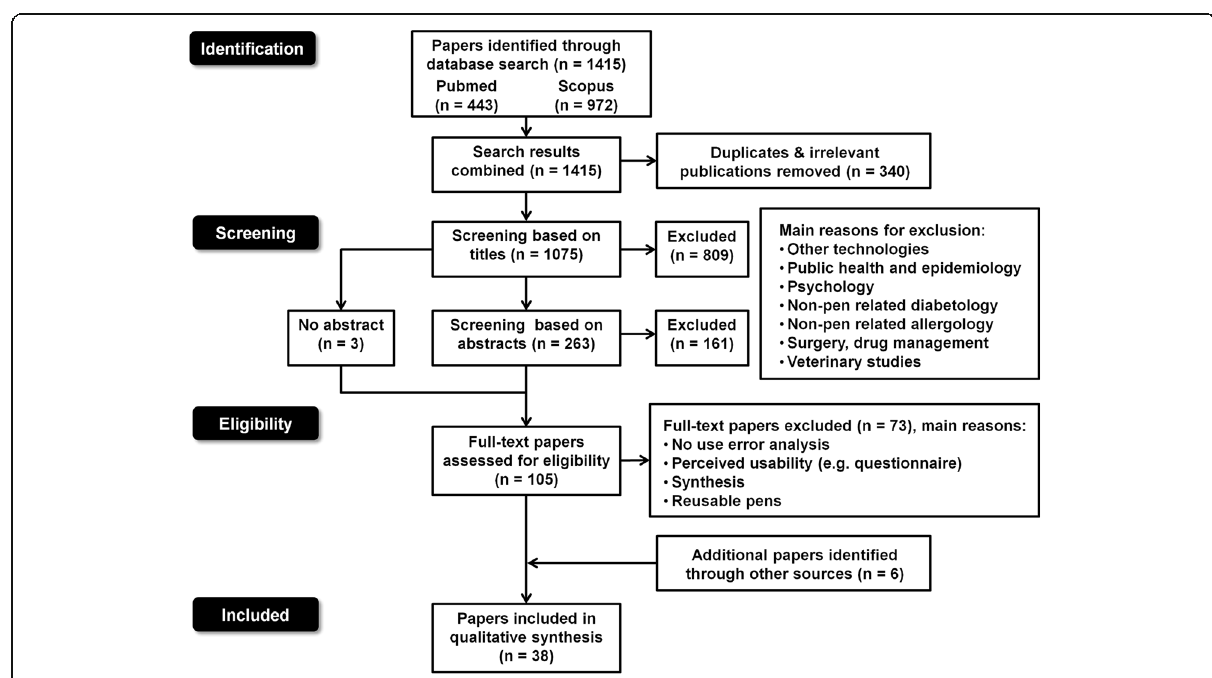
Fig. 3 PRISMA flow diagram for the literature